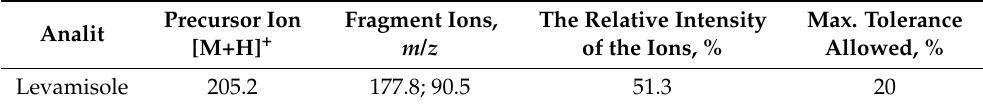
Table 3. Confirmation of identity and specificity.